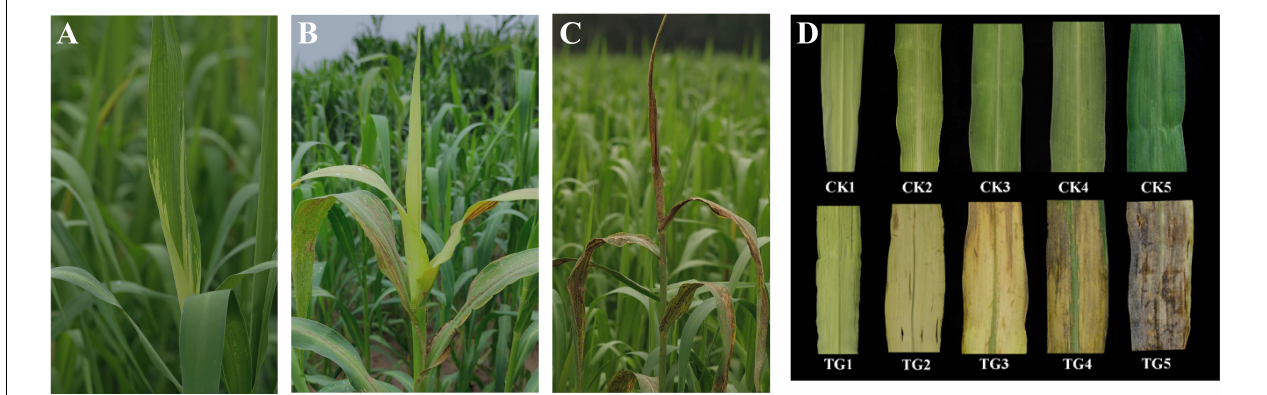
FIGURE 1 | Symptoms of foxtail millet infected by Sclerospora graminicola . (A) The leaf of infected plants at S1 stage; (B) the leaf of infected plants at S3 stage; (C) the leaf of infected plants at S5 stage; (D) morphological characteristics of healthy leaves and infected leaves at S1–S5 stages.